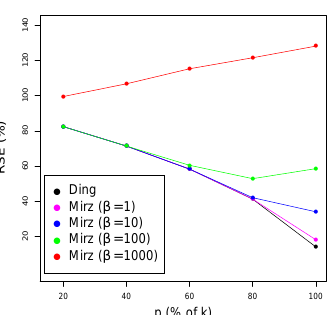
Values of RSE for different values of β obtained by Algorithms 1 and 3 on BION data with n = 100.